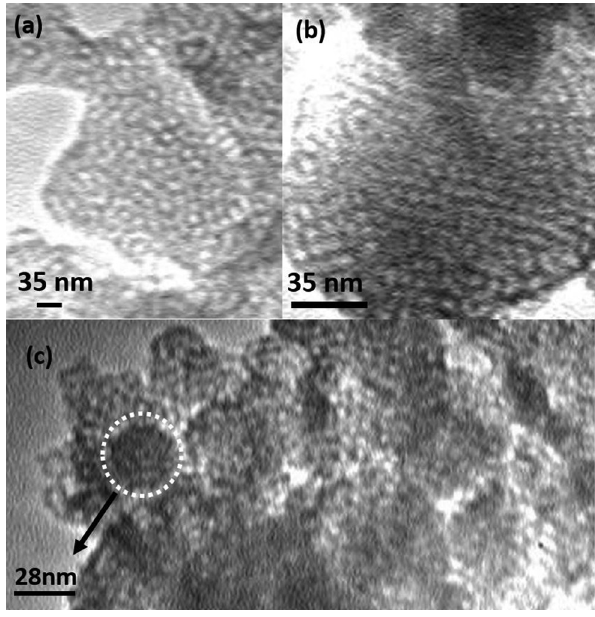
Figure 5: TEM image of MMNP: (a) mesoporous channels of MCM-41, (b) MNPs anchored onto MCM-41 and (c) A 28-nm magnetic core.